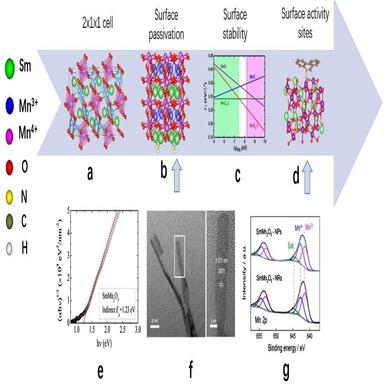
Mullite surface construction process. From 2 × 1 × 1 unit(a), combining experimental structural information such as adsorption spectrum(e), HRTEM(f), XPS (g), etc., to build up the (0 0 1) slab surface model(b) passivated by N and the model supported by N-doped graphene(d). (c) The stability of mullite SmMn2O5 (0 0 1) surfaces at an applied potential of 0.8 V vs. RHE as a function of µSm. Reproduced with permissions from Refs. .